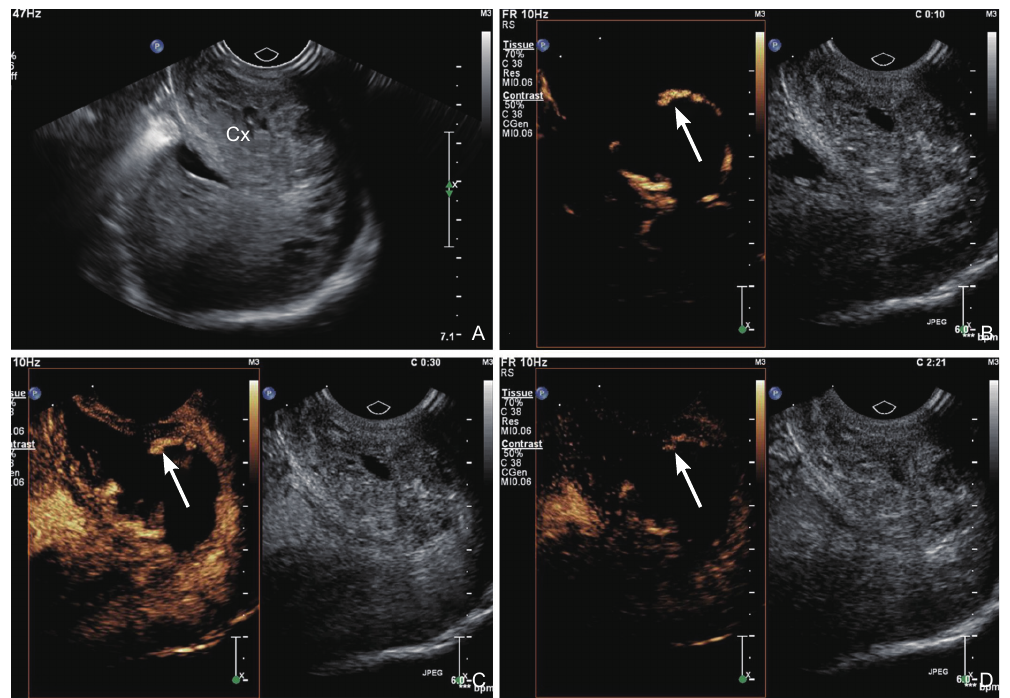
Figure 2 Ultrasonographic findings of Case 2. (A) Transvaginal ultrasonography showed a gestational sac at the cervix canal; (B) The right image shows the fundamental mode, and the left image shows the CEUS mode. The wall of the gestational sac showed rapid enhancement during the early enhancement phase with the performance of hyper-enhanced (white arrow). (C) Enhancement with the sign of doughnut-shaped in the wall of the gestational sac (white arrow); (D) Contrast agents washed out slowly during the late enhancement phase (white